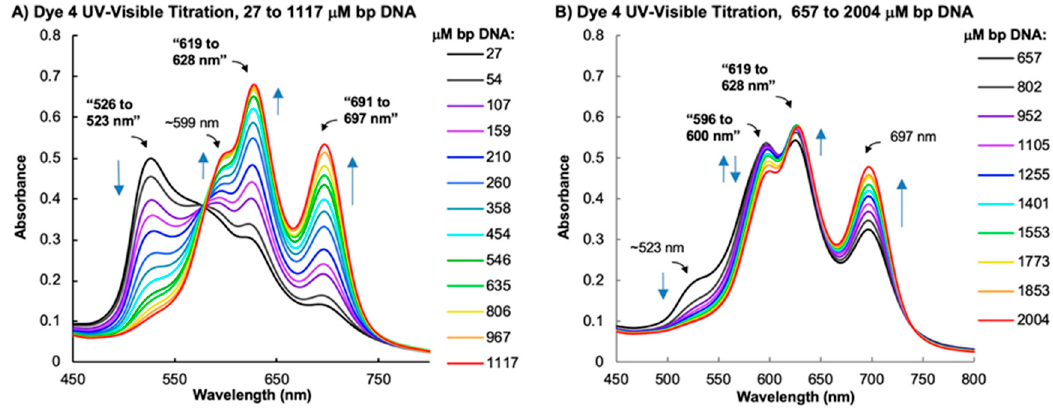
Figure 5. UV–visible absorption titration spectra at 22 °C of 20 µM of dye 4 in the presence of 10 mM sodium phosphate buffer pH 7.0 and CT DNA concentrations ranging: ( A ) 27– 1117 µM bp; and ( B ) 657–2004 µM bp. All absorption spectra are corrected for sample